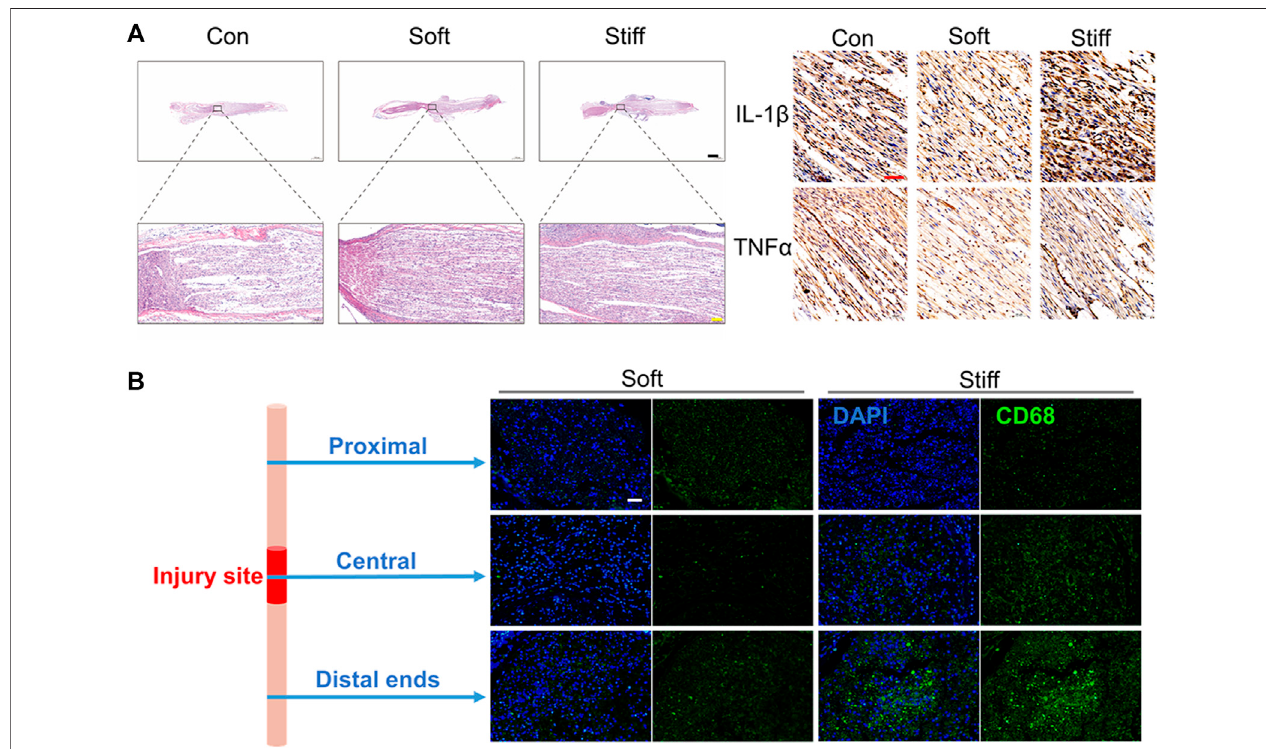
FIGURE 3 | Soft hydrogels loaded with exosomes better repair nerve damage by inhibiting in fl ammation. (A) H&E staining imaging of the injured nerves (left: 14 days, bar = 1,000 μ m black, bar = 100 μ m yellow). Immunohistochemistry imaging of IL-1 β and TNF- α (right: 14 days, bar = 50 μ m red). (B) Immuno fl uorescence imaging of the injured nerves (1 day, bar = 50 μ m, green: CD68, blue: